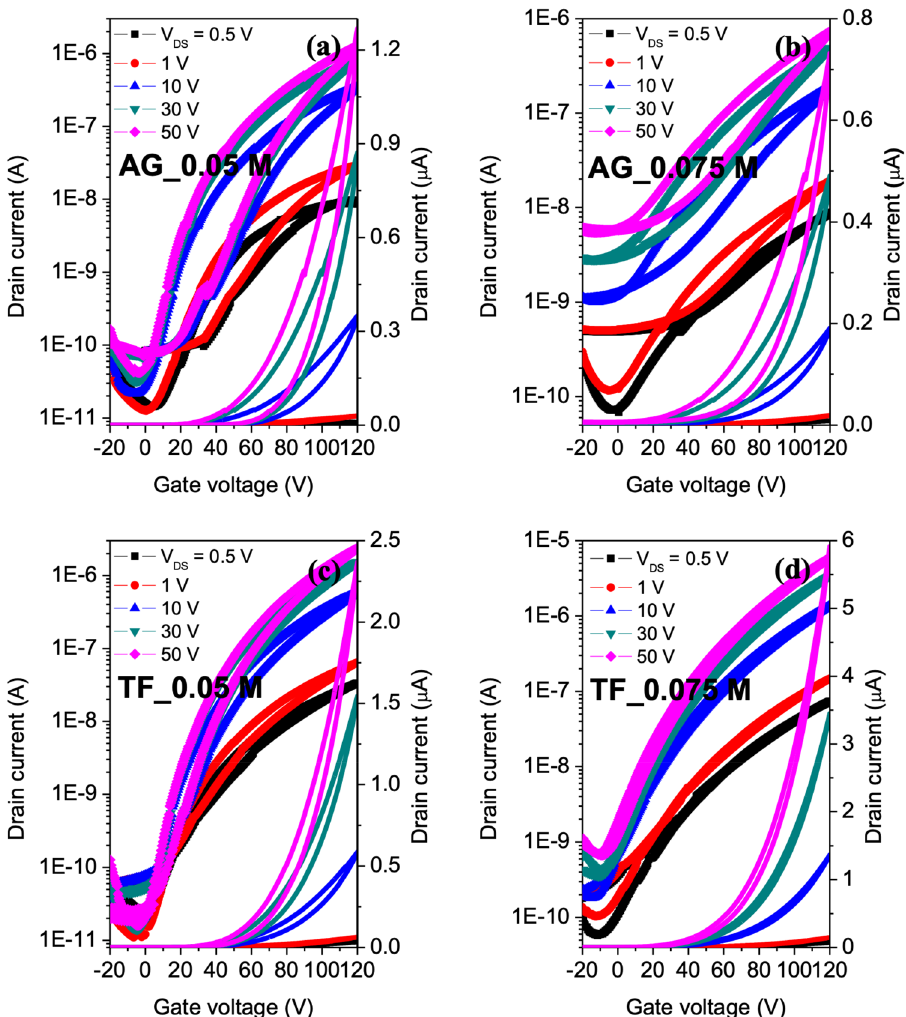
Figure 6. ( a – b ) Hysteresis transfer characteristic of TFTs with as-grown (AG) MoS 2 on SiO 2 /Si and ( c – d ) Hysteresis transfer characteristic of TFTs with transferred (TF) MoS 2 on other SiO 2 /Si prepared form 0.05 and 0.075 M, respectively.